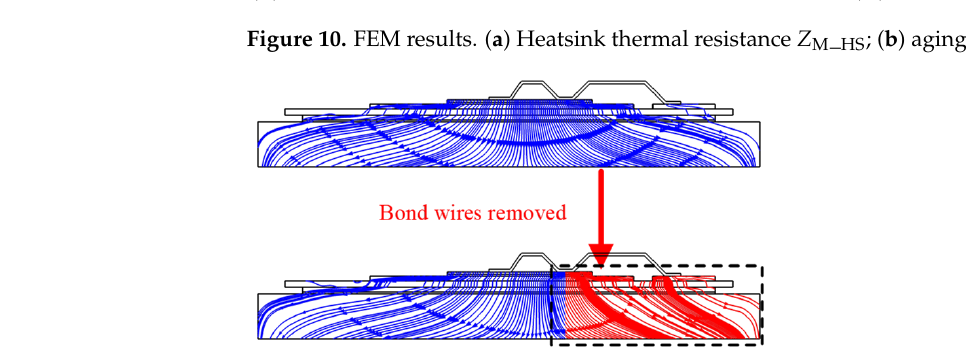
Figure 11. Heat flow in IGBT module after bond wires are removed.